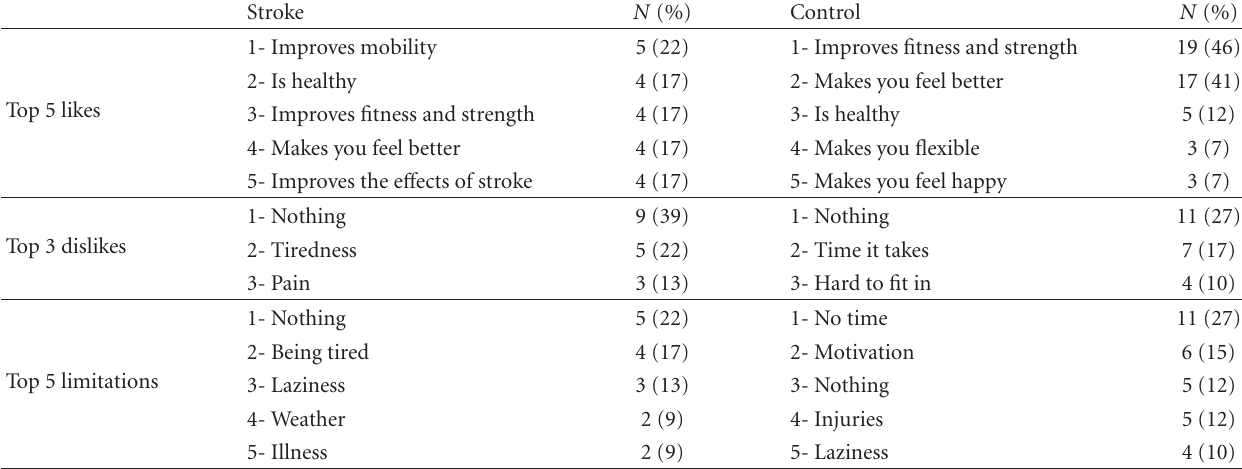
Table 5: Likes, dislikes, and limitations to exercise for stroke survivors and